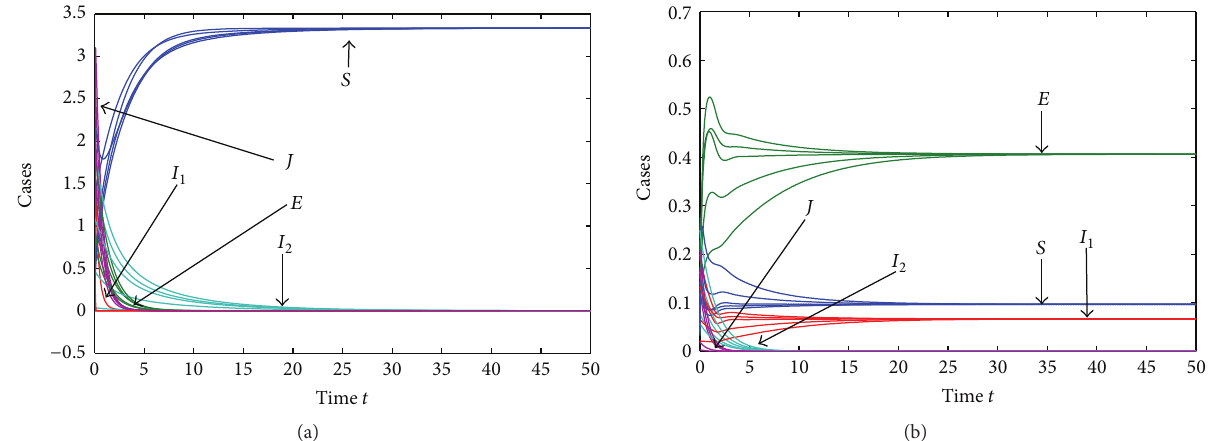
Figure 3: (a) show that 𝐸 0 is globally asymptotically stable. (b) shows that 𝐸 1 is globally asymptotically stable.